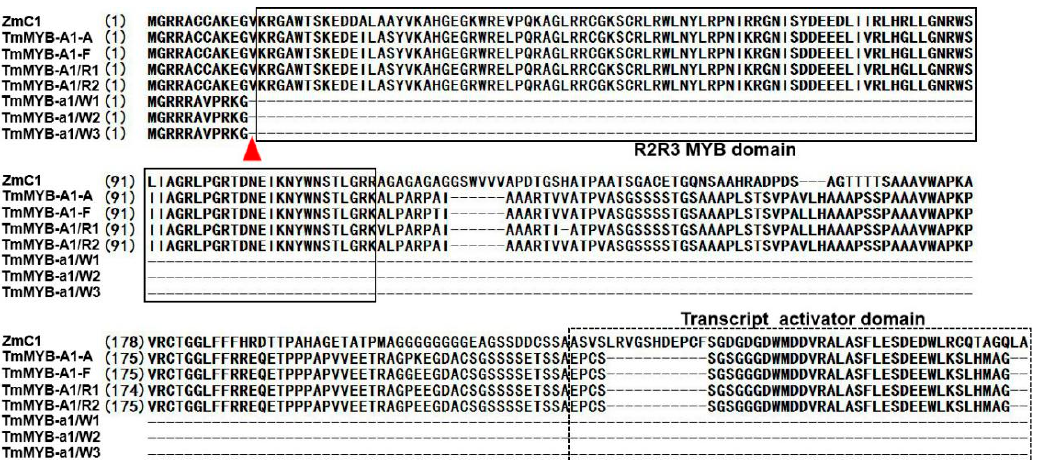
Figure 4. The deduced amino acid sequence alignment of TmMYB-A1 from R1, R2, W1, W2, W3, and MYBs, which regulate anthocyanin biosynthesis in other species. The solid frame represents the R2R3 MYB domain and the dotted frame represents the transcript activator domain. The red triangle represents the location of the stop codon.